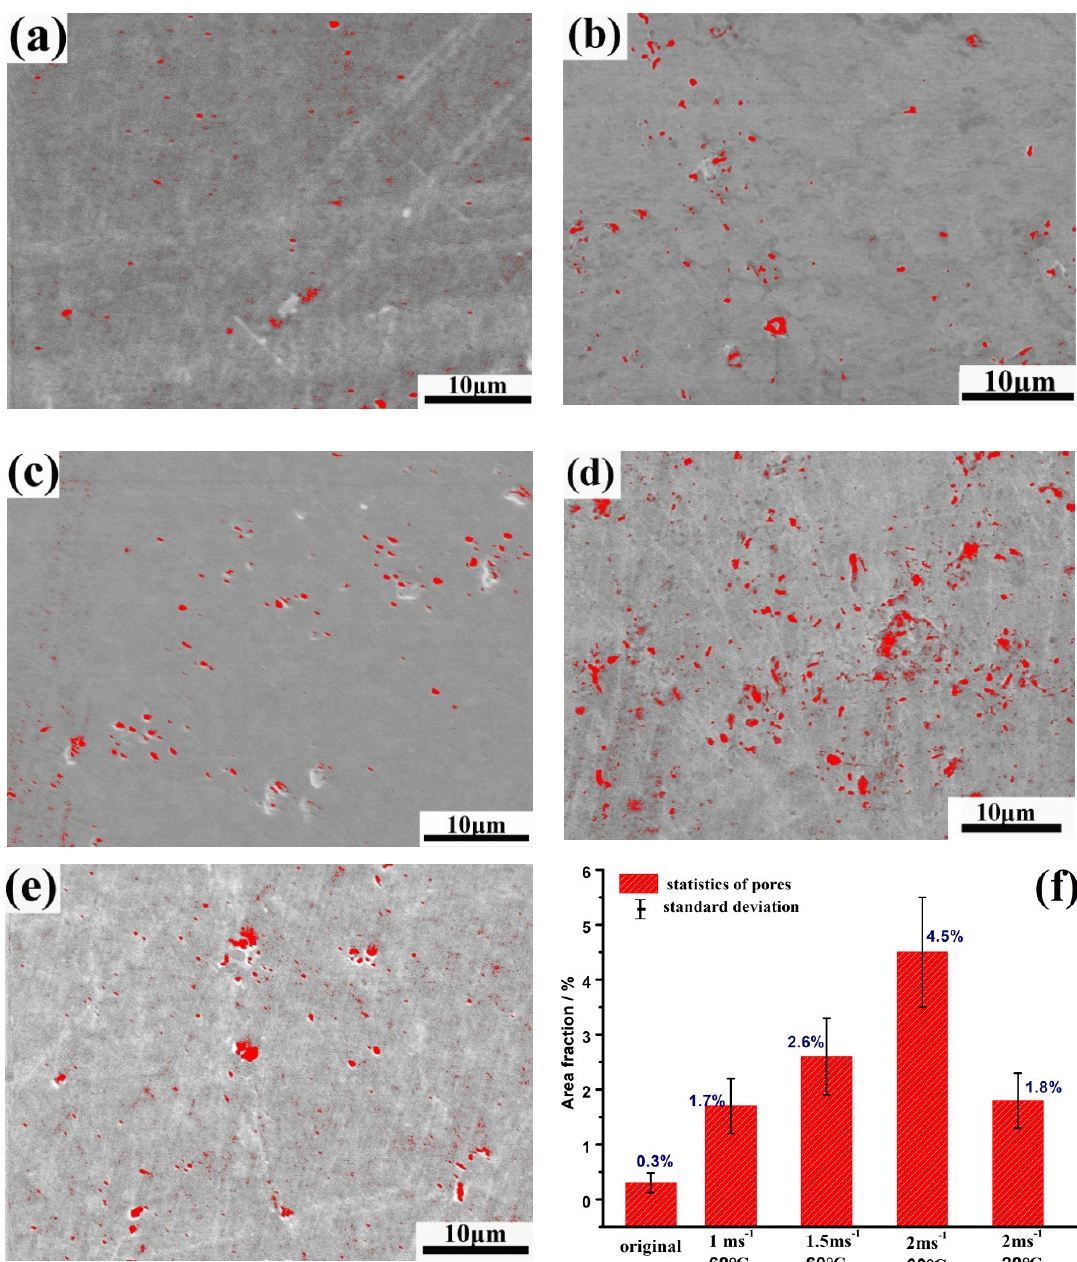
Figure 5. SEM image of the W–Cr–C coated tungsten samples (the red refers to the pores): ( a ) before corrosion; ( b ) corrosion at 1 ms −1 , 60 °C; ( c ) corrosion at 1.5 ms −1 , 60 °C; ( d ) corrosion at 2 ms −1 , 60 °C; ( e ) corrosion at 2 ms −1 , 20 °C; and ( f ) the bar chart of pitting fraction with velocity and temperature.